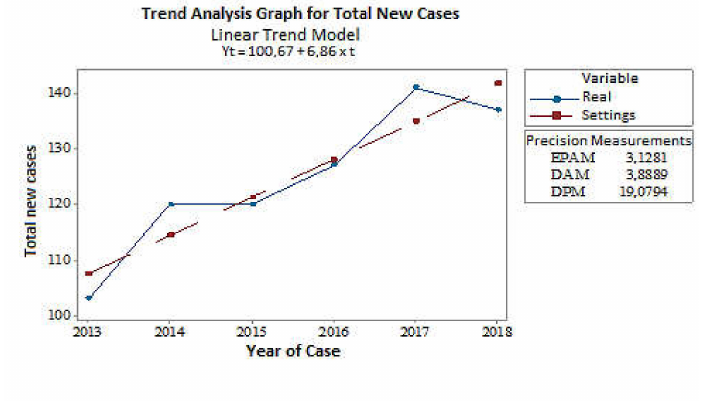
Figure 1. A temporal series for analyzing the trend of new cases of human tuberculosis on the Maraj ó Island, Par á -Brazil, from 2013 to 2018. The variable “Real” means absolute data, while the variable “Settings” means linear model. Source: Research protocol